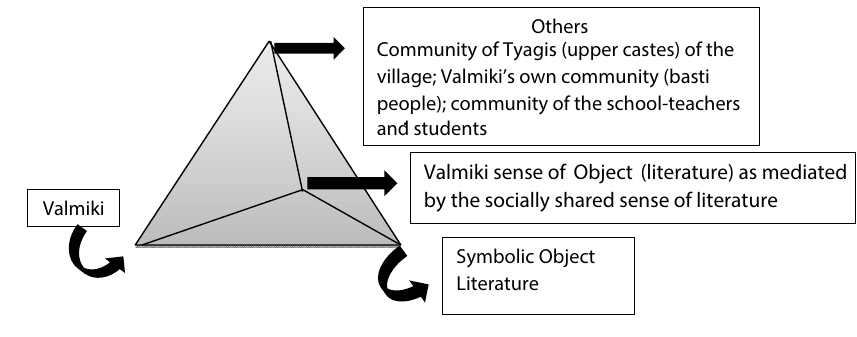
Fig. 1: Semiotic Prism before